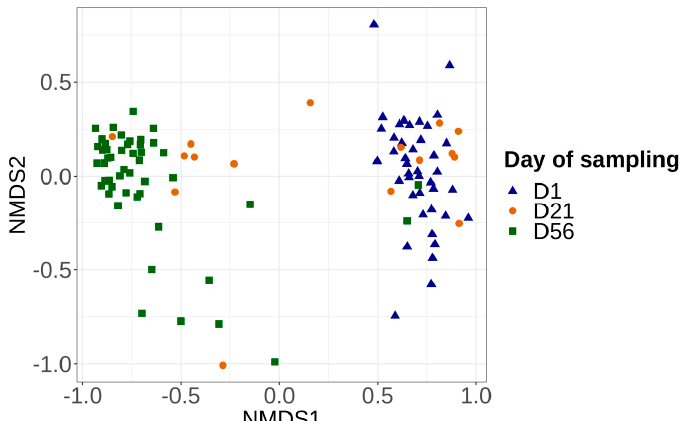
Figure 4. Non-metric multidimensional scaling plot (NMDS) illustrating beta diversity, calculated with the Bray–Curtis index according to the day of sampling (D1, D21, D56). Significant differences were found in the vacuum-packed surface microbiota between day 1 and 21, as well as day 1 and 56. No significant difference between day 21 and 56 was